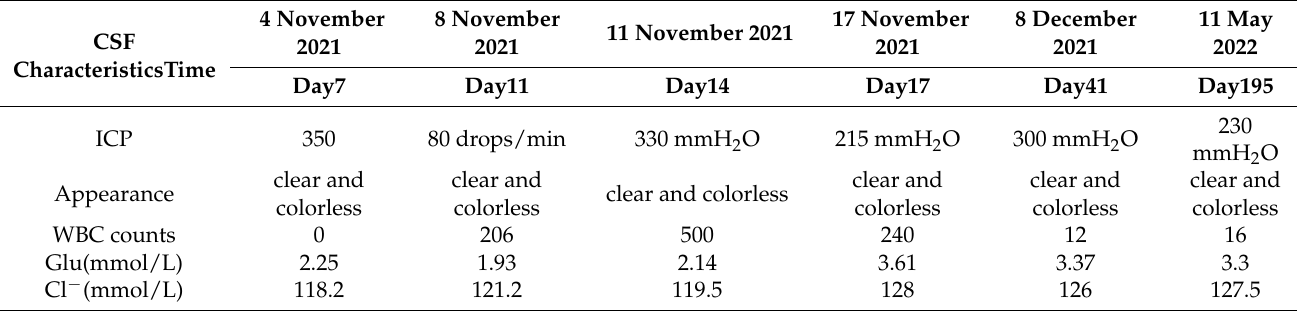
Table 1. Characteristics of the patient’s